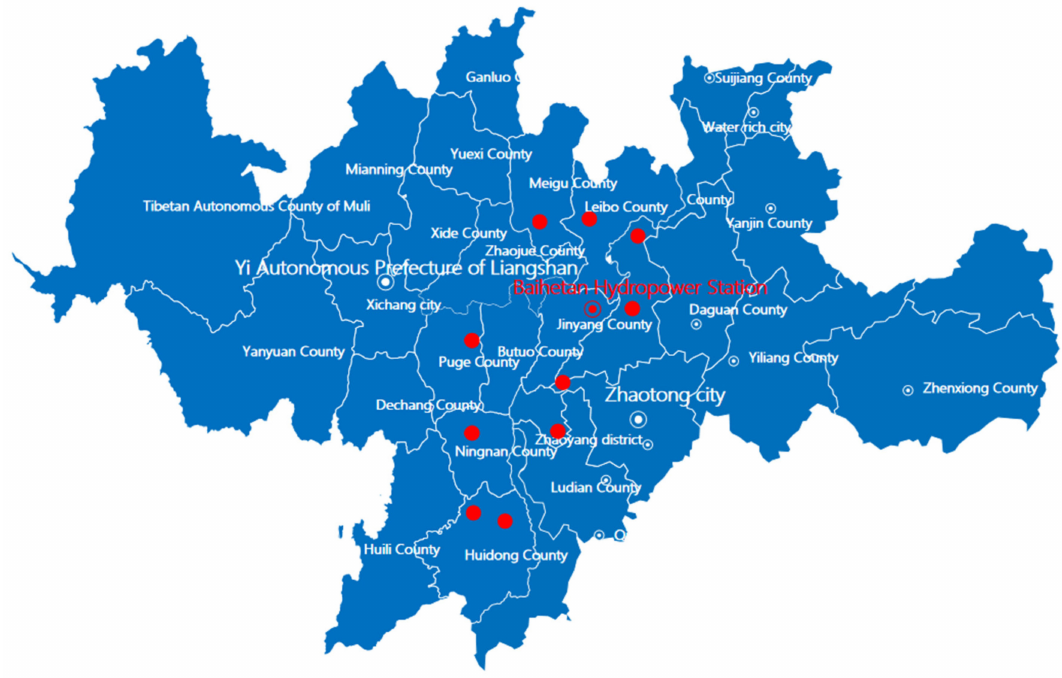
Figure 1. Geographical Location of Hydropower Station. The ground meteorological data used are from 10 meteorological monitoring stations distributed in the area. The meteorological data in the area, including air pressure, air temperature and wind speed, are collected by hour. The air temperature dataset was obtained from 10 meteorological monitoring stations within the study area for a total of approximately 30 months of hourly air temperature observations from 2018 to 2020, including hourly mean air temperature, minimum air temperature, maximum air temperature, average air temperature, location (longitude and latitude) and time stamp for a total of 220,429 entries. Some sample data are shown